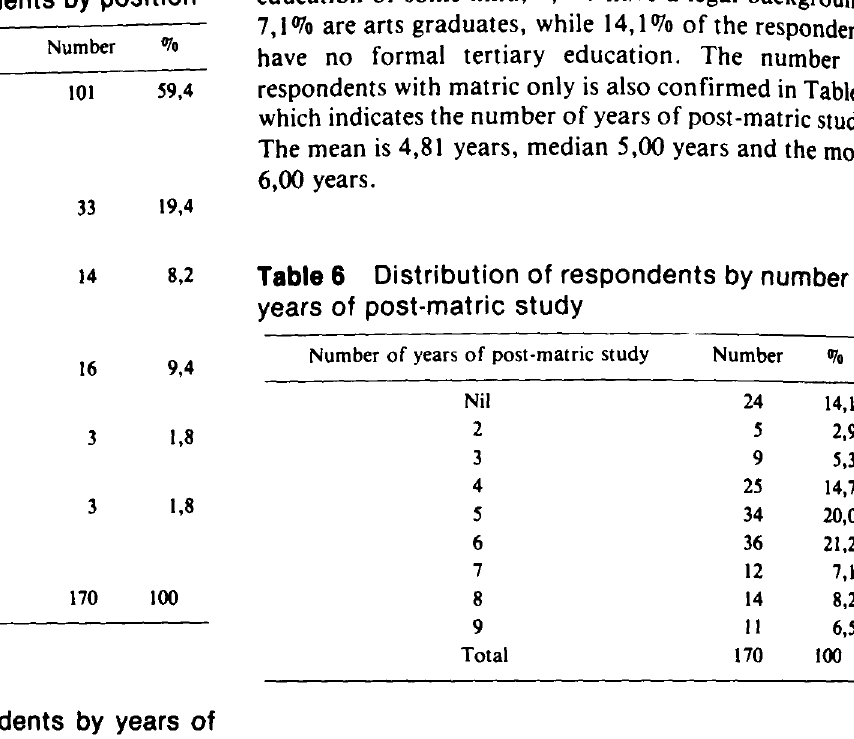
Distribution of respondents by years of